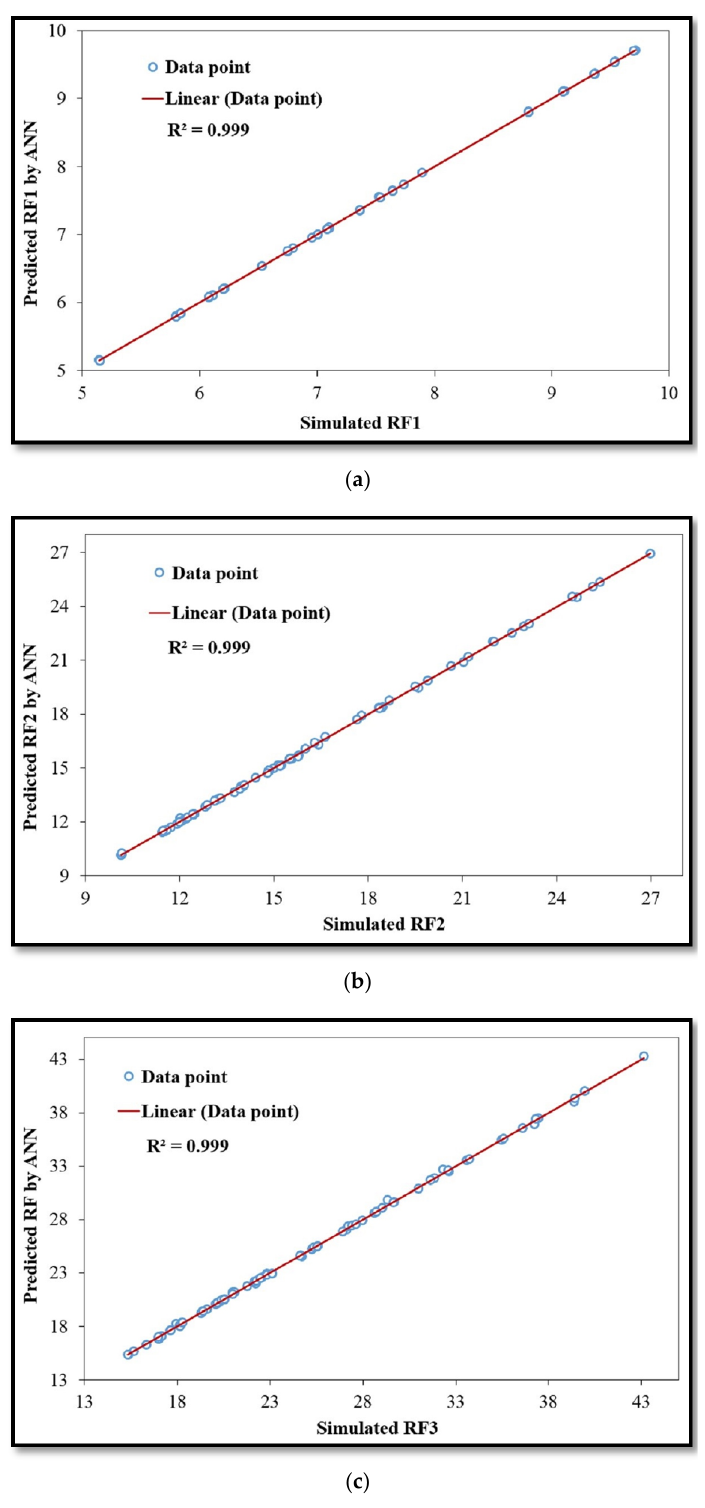
Figure A2. Illustration of the correlation coefficient for predicted data against the simulated data during the validating process for ( a ) RF 1 , ( b ) RF 2 , and ( c ) RF 3 .